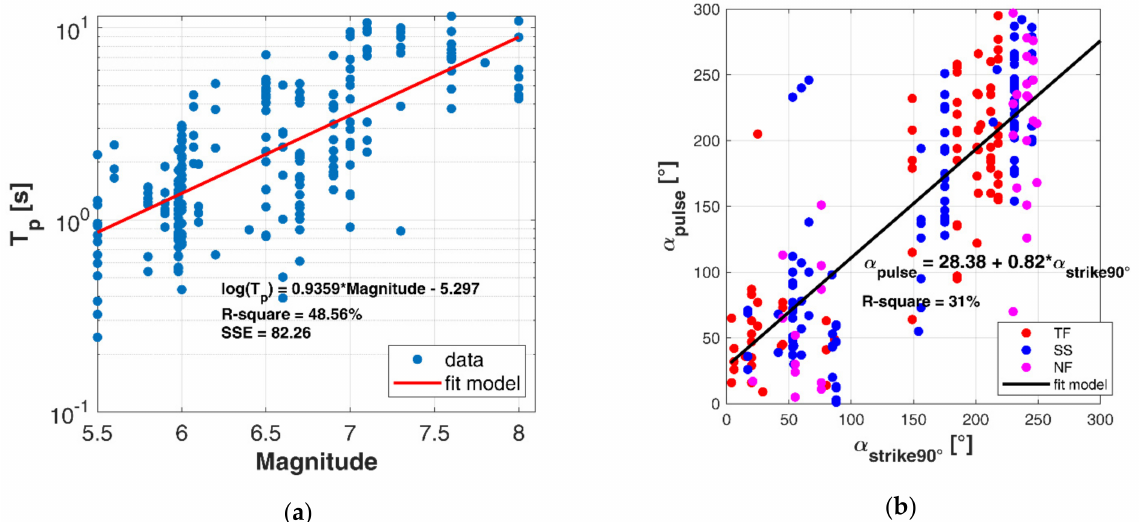
Figure 2. Scatter plot of the pulse period T p versus Magnitude along with the fitting function Equation (1); the Root-Mean- Squared_error RMSE is equal to 0.6043 and the statistical coefficient of determination R-square is 48.56% ( a ), relationship between pulse azimuth α pulse and strike normal angle α strike90 ◦ for Strike-Slip (SS), Thrust-Fault (TF) and Normal-Fault (NF)—RMSE 172.2 and R-square 31% ( b